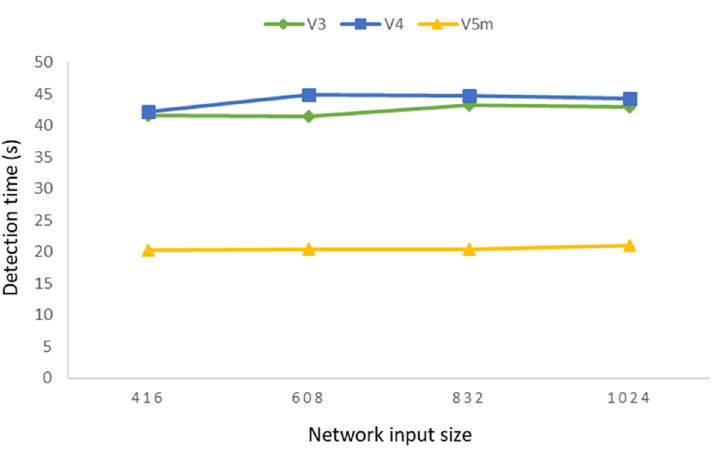
Figure 12. Comparison of the average detection time of YOLOv3, YOLOv4, and YOLOv5m.